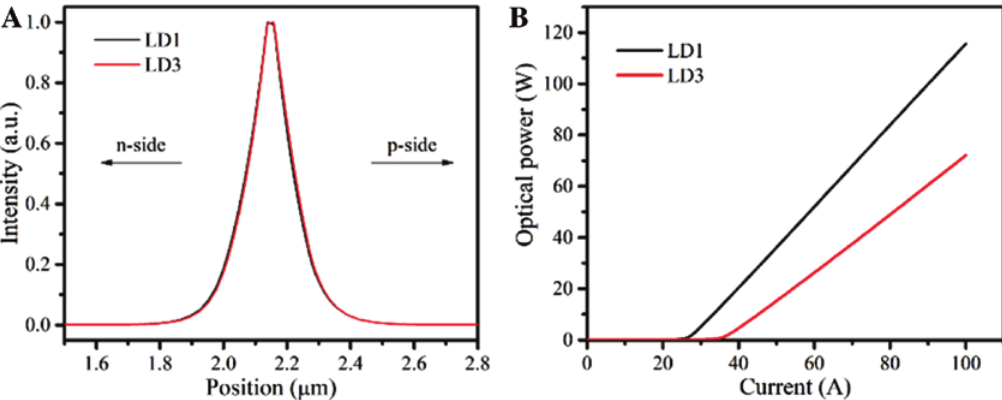
Ga N upper waveguide layer. Moreover, the 0.017 0.983